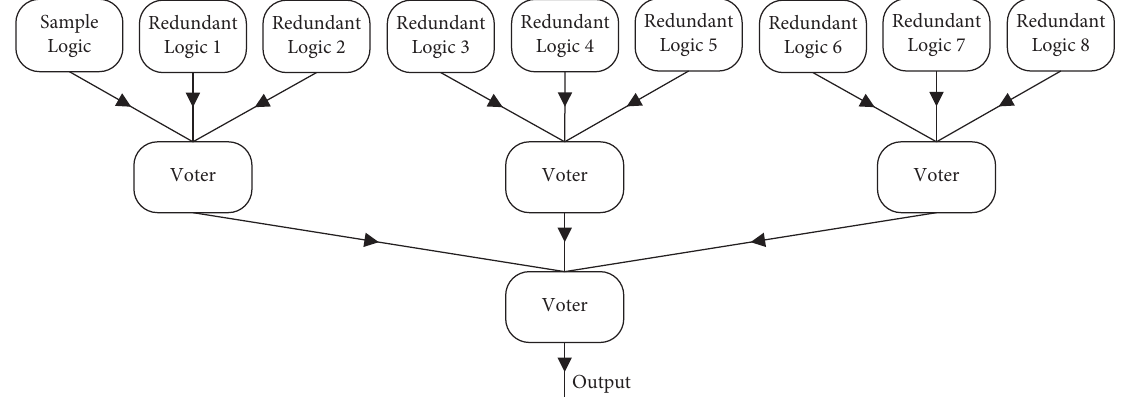
Figure 3: Cascaded TMR-level